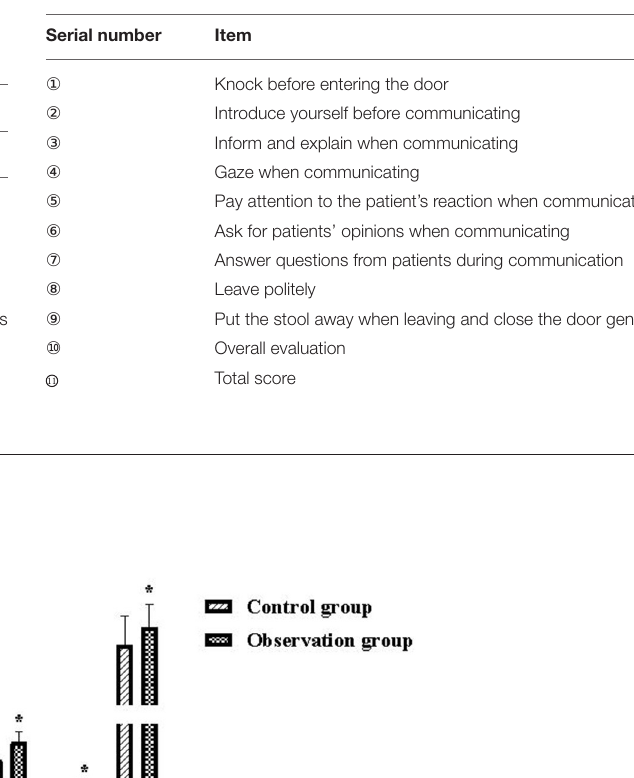
TABLE 3 | Clinical communication behavior scale of new nurses.